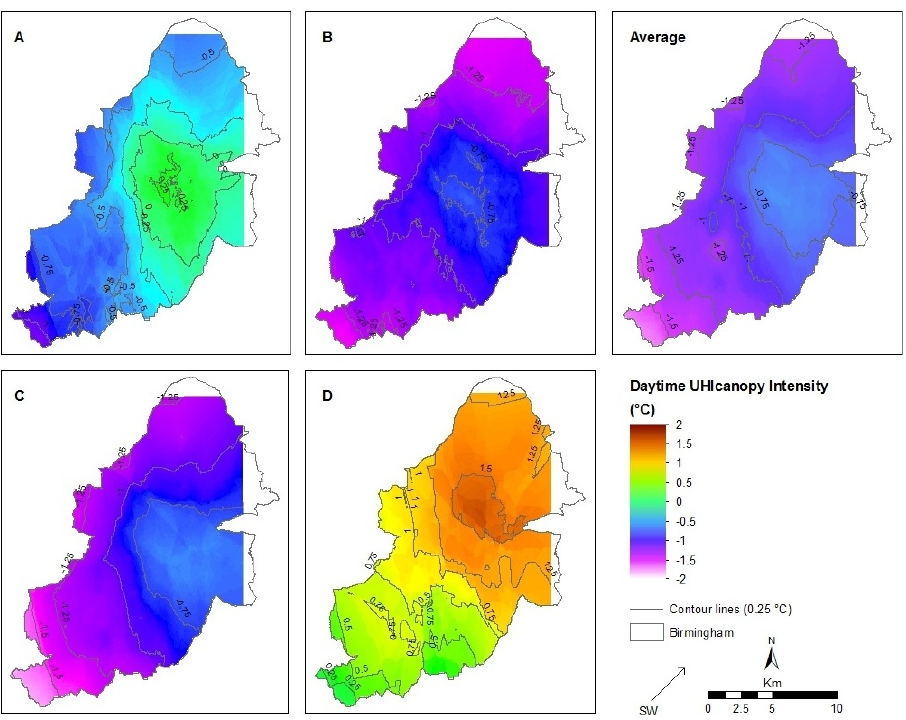
Figure 3. Daytime UHI canopy intensity, for Pasquill-Gifford Stability Classes ( A ); ( B ); ( C ) and ( D ); and Average for June, July, August 2013 and prevailing wind direction for the period. Based on the BUCL dataset.